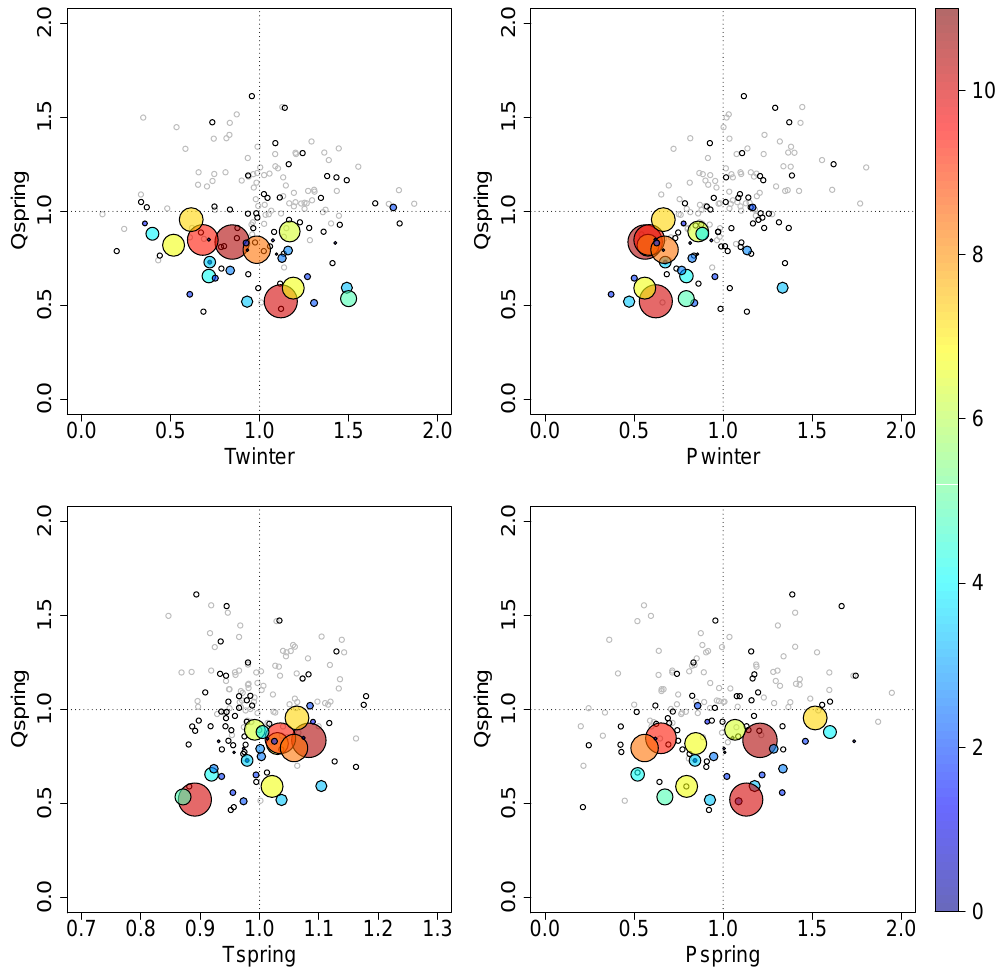
Figure 5. Snowmelt drought events in Norwegian catchments: standardised spring discharge ( Q spring ) (–) against standardised causing factors ( T winter , P winter , T spring , P spring ) (–). Below 1 = below average; above 1 = above average. Grey circles: all years; black circles: all drought years; coloured circles: snowmelt drought years (size and colour of dots are dependent on standardised drought deficit (–); scale on the right side of the figure).